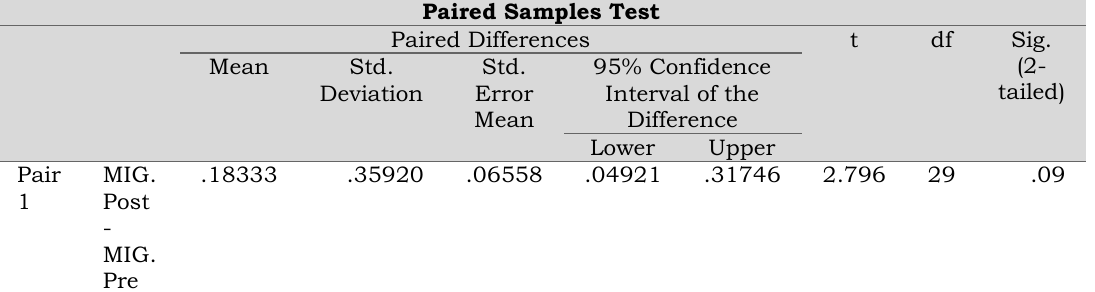
Table 6. Results of paired-samples t-test comparing the pretest and posttest scores of the CG